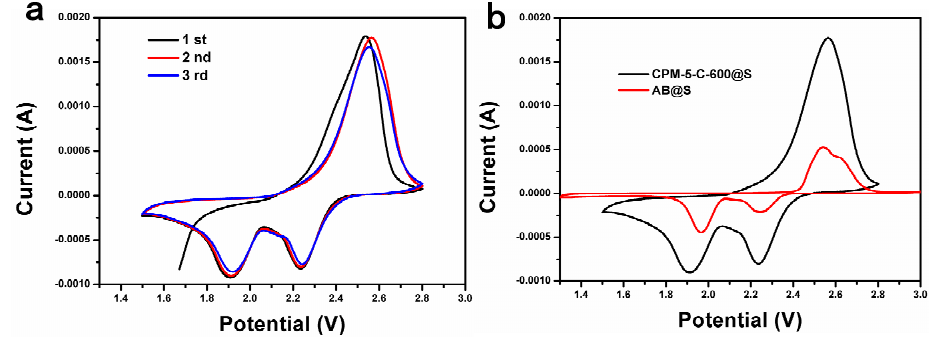
Figure 6. Cyclic voltammetry (CV) curves of ( a ) CPM-5-C@S electrodes at a scanning rate of 0.1 mV s − 1 range from 1.3 to 3.0 V with 5 cycles; ( b ) CV curves of CPM-5-C@S and AB@S electrodes at the second cycle.